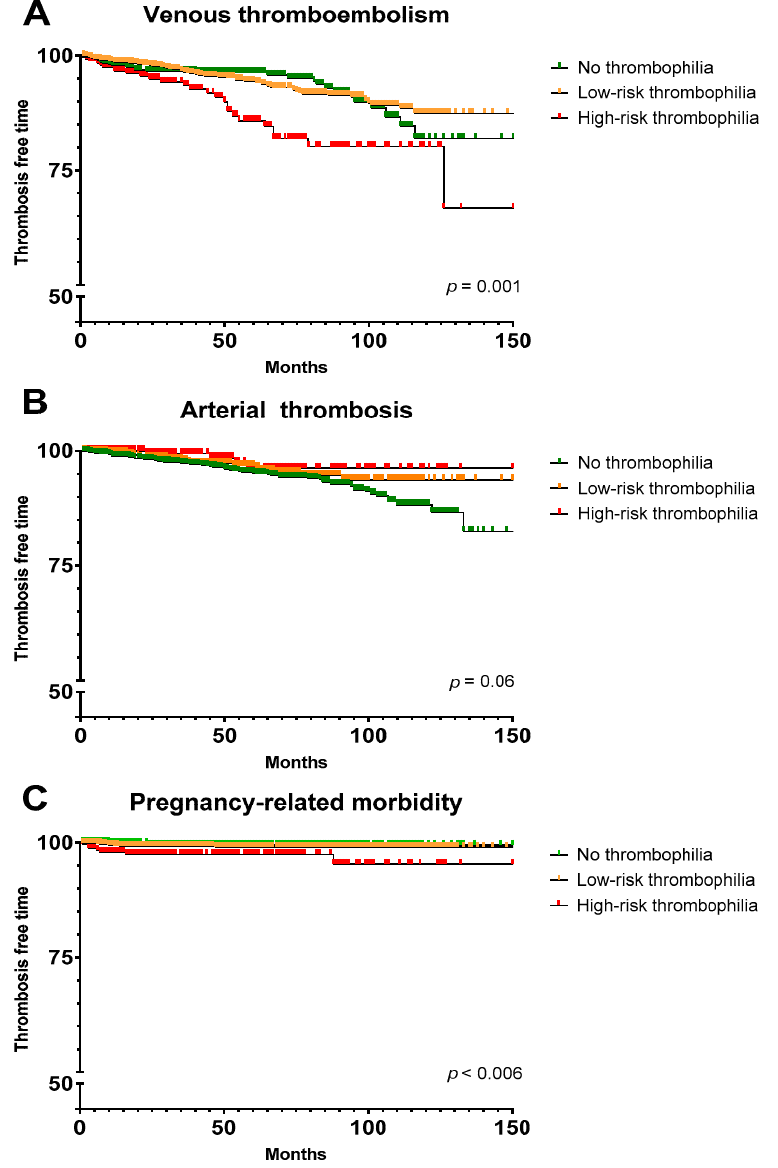
Figure 3. Kaplan–Meier survival curves in patients with no thrombophilia, low-risk thrombophilia and high-risk thrombophilia. ( A ) Patients with subsequent venous thromboembolism. ( B ) Patients with subsequent arterial thrombosis. ( C ) Women with subsequent pregnancy-related morbidity.